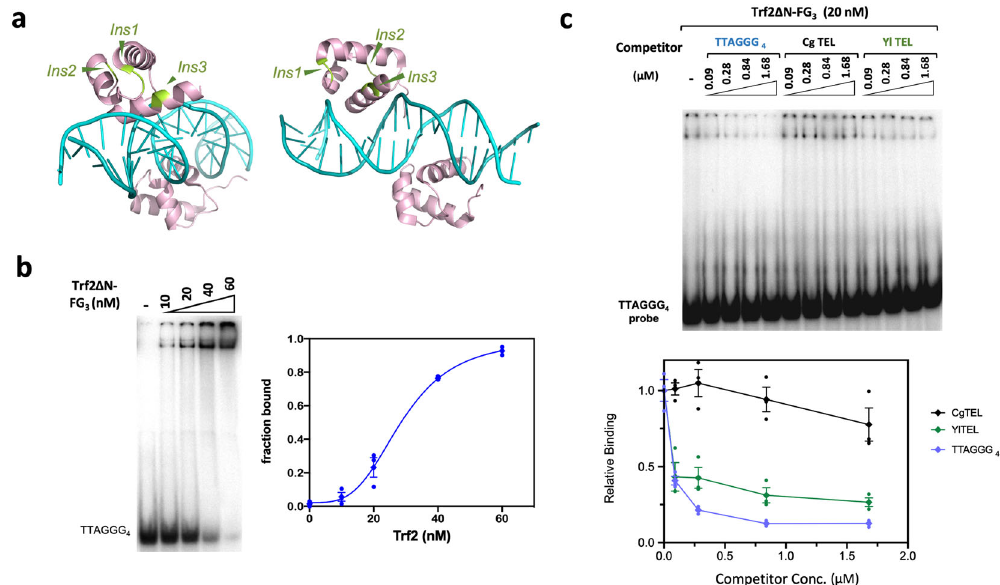
Fig. 2 The DNA-binding activity of Ustilago maydis Trf2. a The structure of human TRF1 – DNA complex is used to illustrate the locations of three insertions within the Myb domain of U. maydis Trf2. The positions where the insertions occur are shown in light green. Note that these are all positioned away from the DNA – protein interface. b EMSA analysis was performed using varying concentrations of Trf2 Δ N-FG 3 and double-stranded telomere oligonucleotides. A representative series of assays is shown and the quanti fi ed results (average ± SEM, n = 3 independent experiments) plotted on the bottom. c The DNA-binding speci fi city of Trf2 was examined using the same competitor oligonucleotides as in Fig. 1c. A representative series of assays is shown and the calculated results (average ± SEM, n = 3 independent experiments) plotted on the